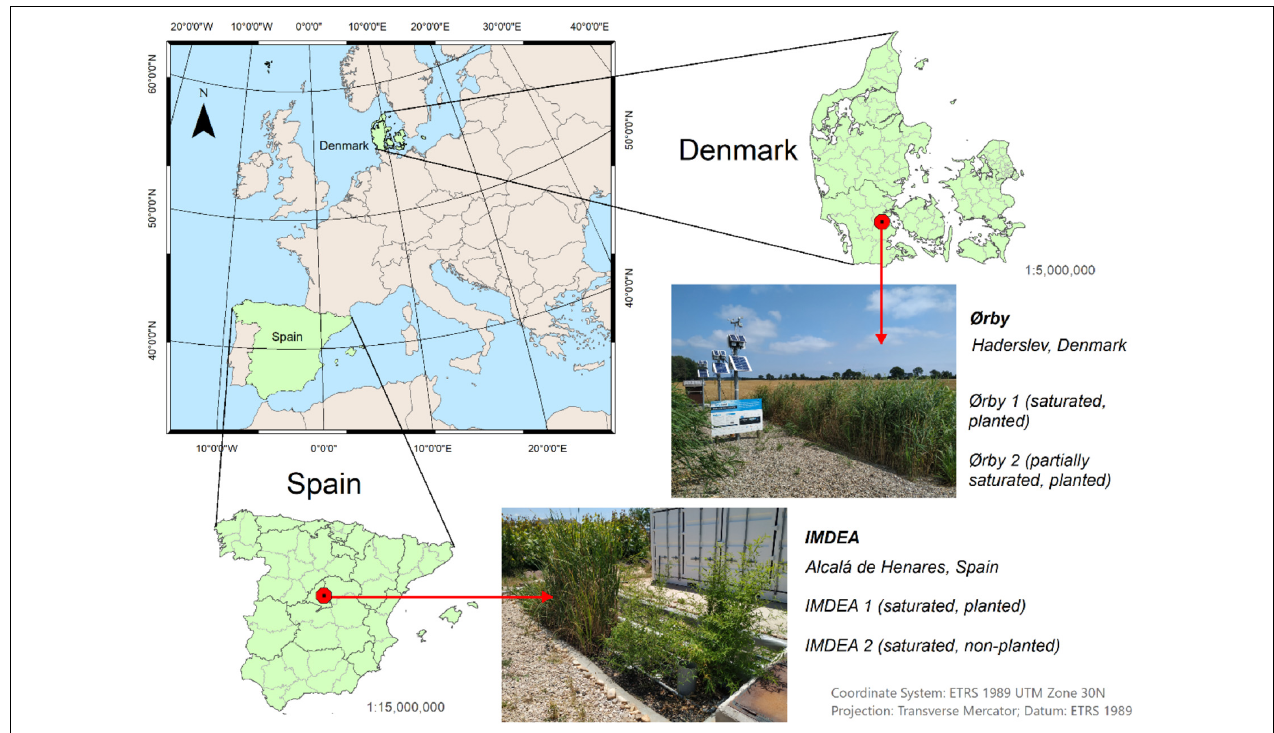
FIGURE 1 | Location map of the METlands analyzed in the